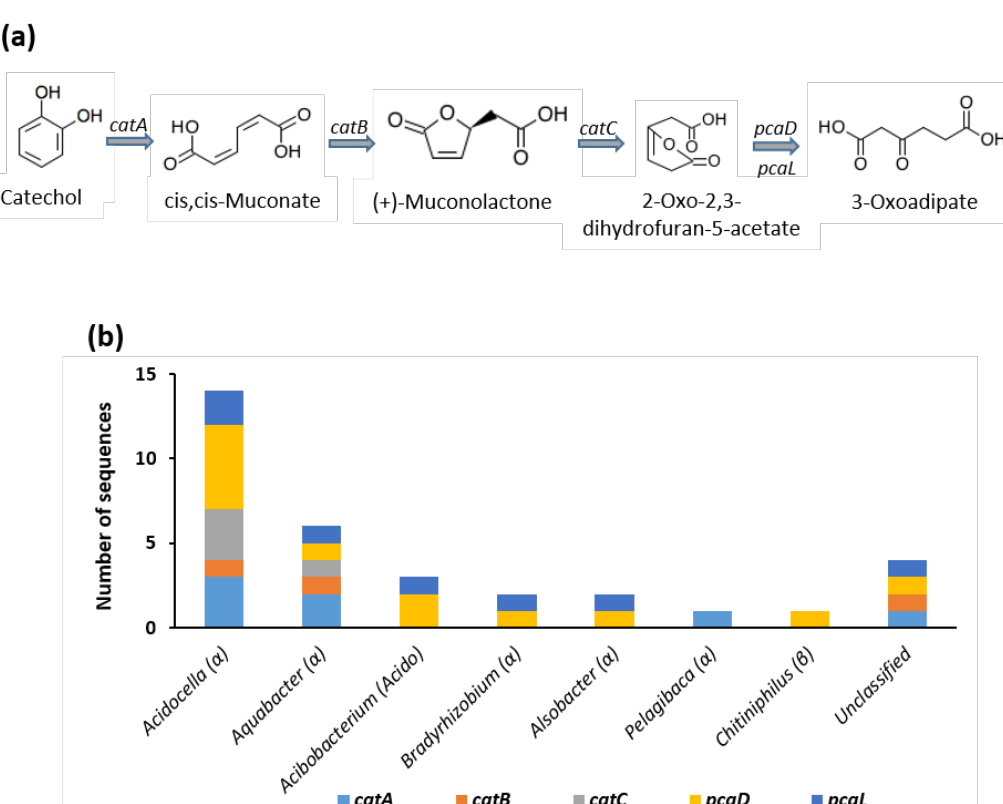
Figure 3. ( a ) Ortho-cleavage of catechol. ( b ) Genus assignation of the genes involved in ortho-cleavage of catechol and subsequent degradation reactions. Symbol (or letters) in parenthesis indicate the taxonomic class of each genus. catA : catechol 1,2-dioxygenase; catB : muconate cycloisomerase; catC : muconolactone D-isomerase; pcaDL : 3-oxoadipate enol- lactonases.